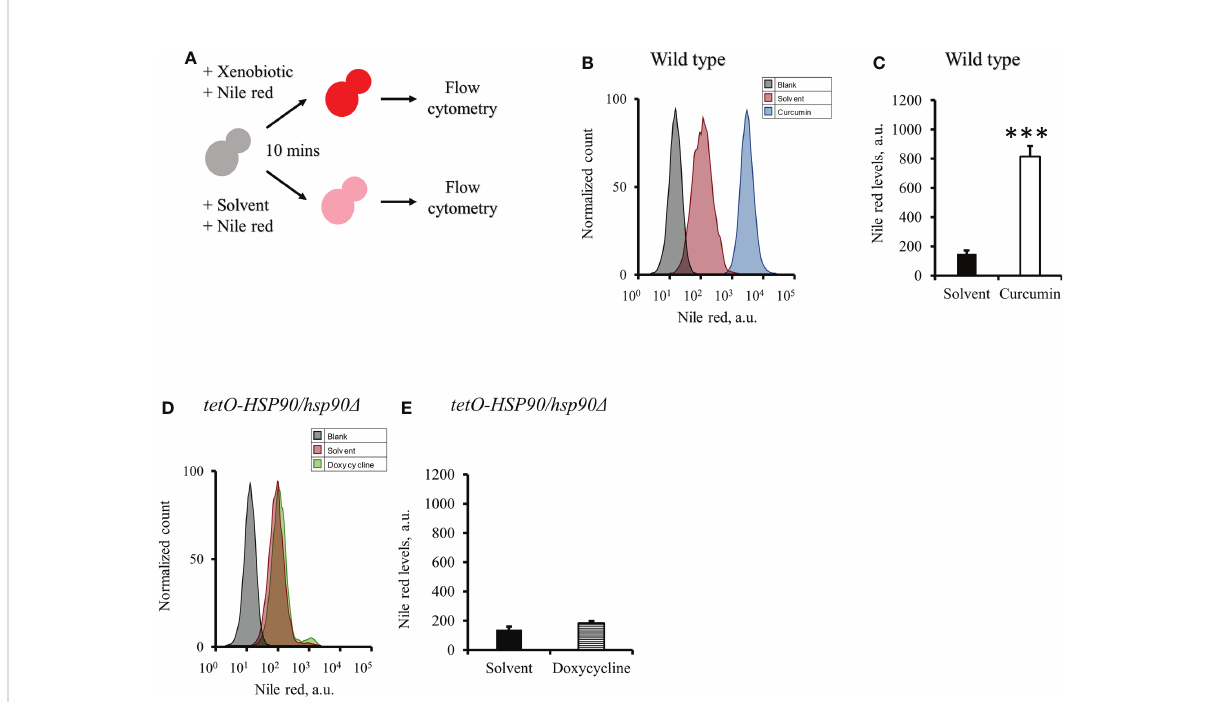
FIGURE 9 Effect of curcumin on the ef fl ux pump activity of C. albicans . (A) Diagram showing the Nile red accumulation assay for determining the ability of curcumin to inhibit the ef fl ux pump. (B) The amount of the Nile red accumulated in C. albicans SC5314 was determined after it was treated with curcumin for 10 minutes. (C) The fl ow cytometry histograms for the mean Nile red fl uorescence. (D) The amount of the Nile red accumulated in tetO-HSP90/hsp90 D was determined after it was treated with doxycycline for 10 minutes. (E) The fl ow cytometry histograms for the mean Nile red fl uorescence. Error bars represented standard deviation from the mean of duplicate measurements. *** indicates a statistically signi fi cant difference (p<0.001) compared to the respective control